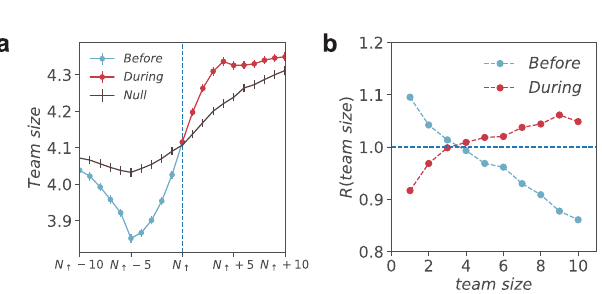
Fig. 4 Authorship structure and hot streaks in science. a The average team size around the beginning of a hot streak for real and randomized careers in science. Team size shows a signi fi cant drop before a hot streak begins, but a notable increase during hot streak. b We calculate team size for papers published before and during hot streak, and compare the distribution to that of randomized careers for 500 realizations, denoted as R (team size). R decreases with team size from above to below 1 for papers published before a hot streak but increases with team size for papers published during a hot streak. Both measures in ( a ) and ( b ) suggest that scientists tend to engage with smaller teams before hot streak, and with larger teams during the hot streak. Error bars represent the standard error of the